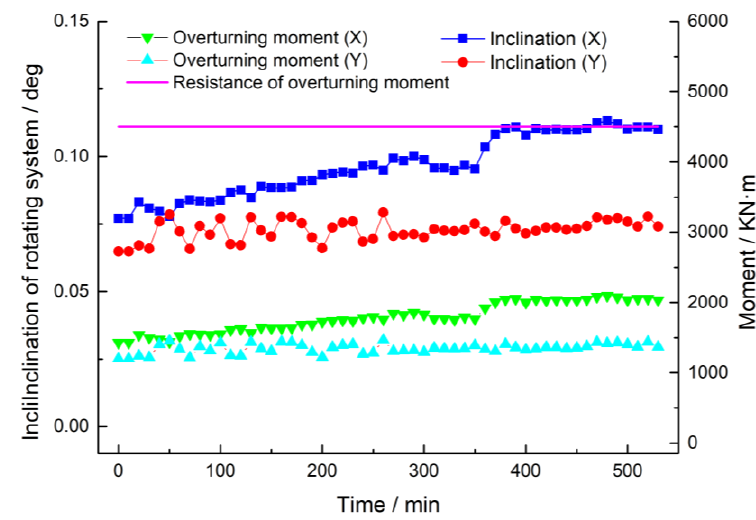
Figure 17. The rotating system’s inclination and overturning moment.